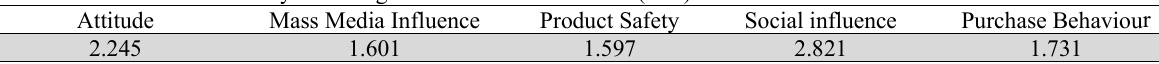
The Result of Multicollinearity test using Variance Inflation Factor